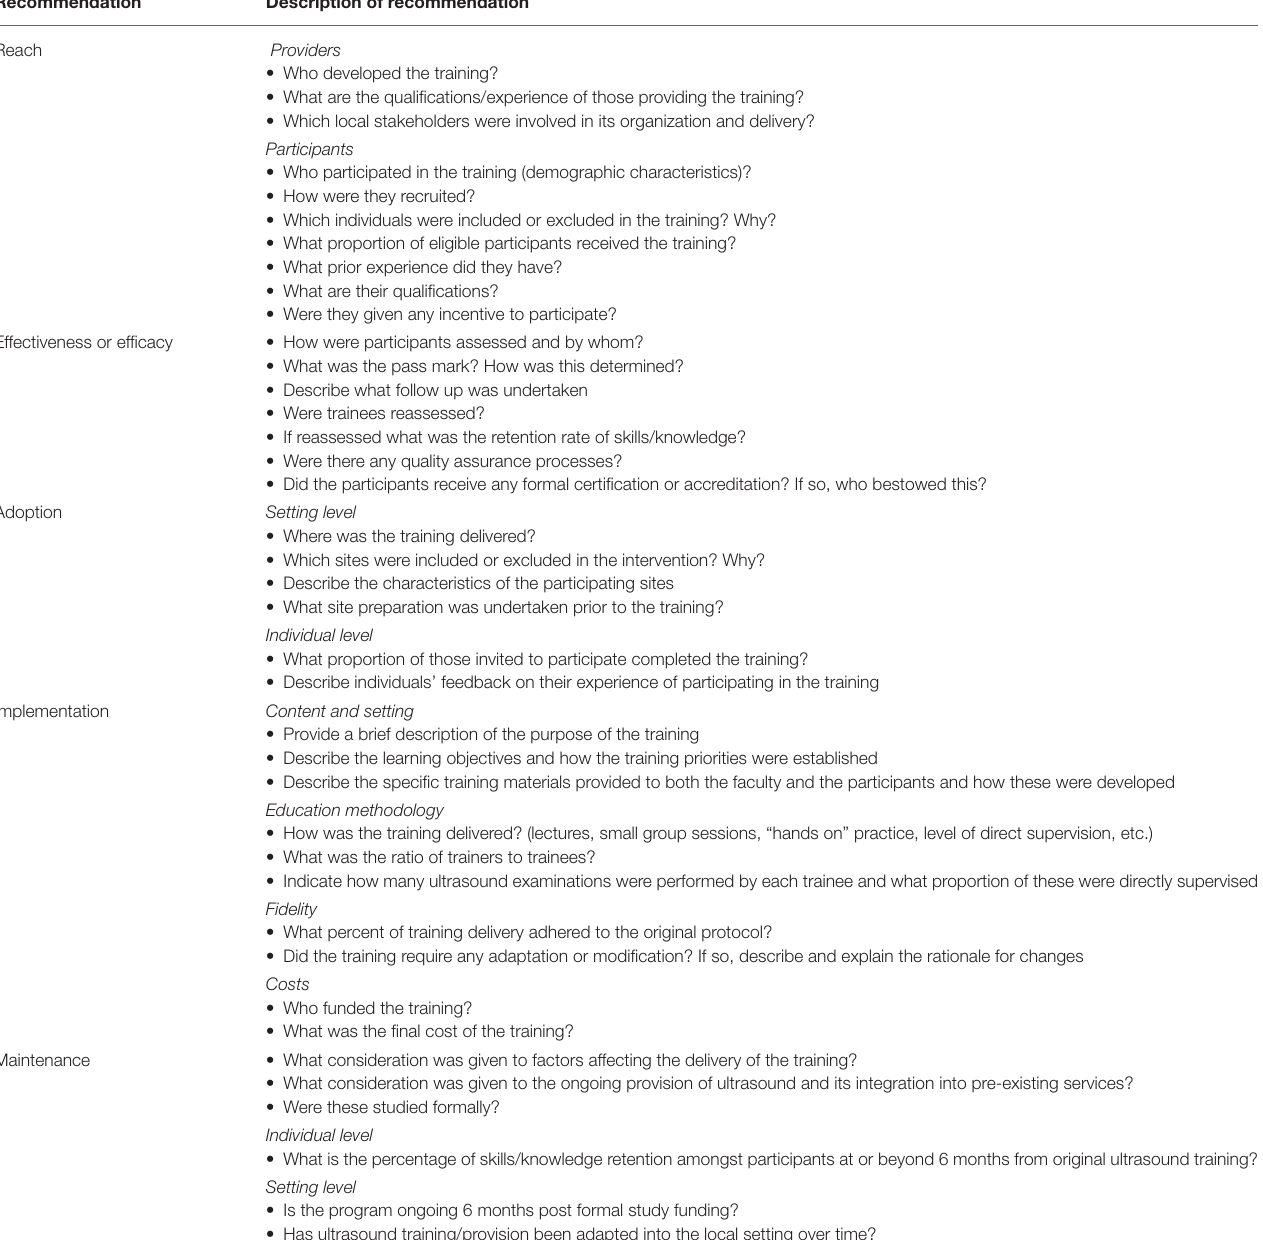
TABLE 3 | Recommendations for the design and delivery of ultrasound training programmes presenting within the RE-AIM framework.